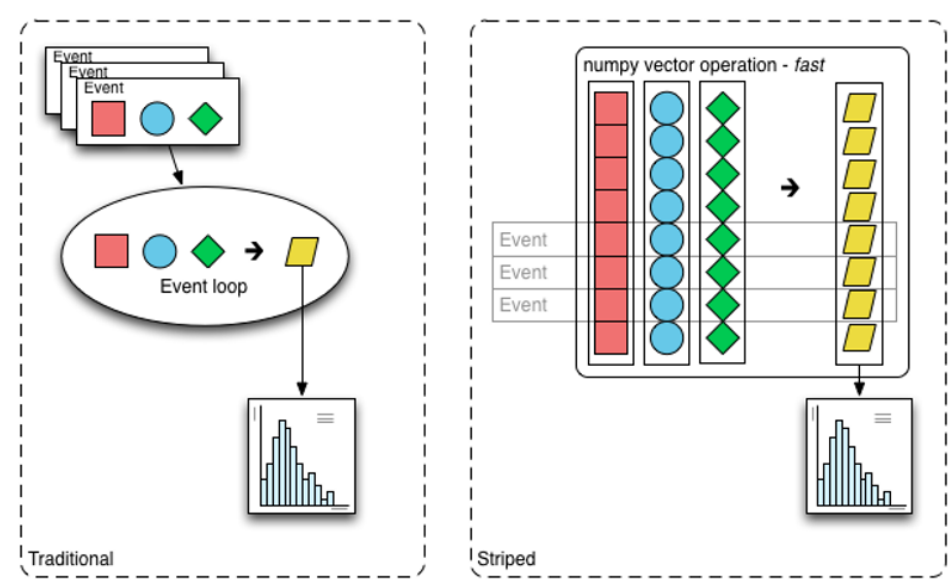
Figure 3. Moving calculations from event loop to